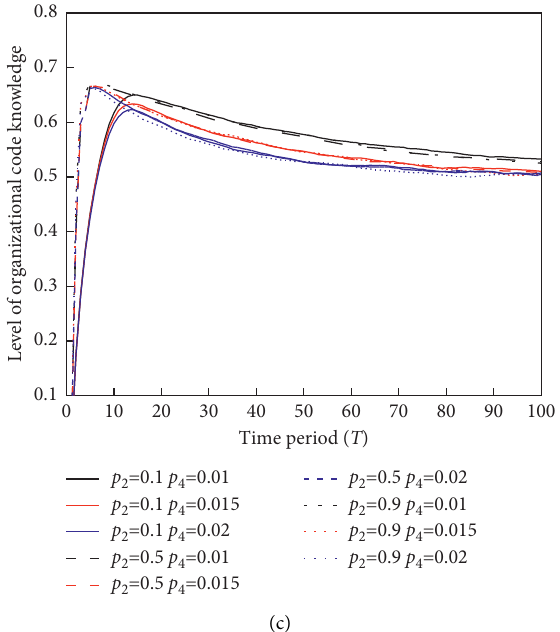
Figure 5: Effects of codification rate ( p 2 ) on the level of organizational code knowledge at different socialization rates ( p 1 ) over time in the turbulent environment and closed system ( p 3 � 0). (a) p 1 � 0.1. (b) p 1 � 0.5. (c) p 1 �